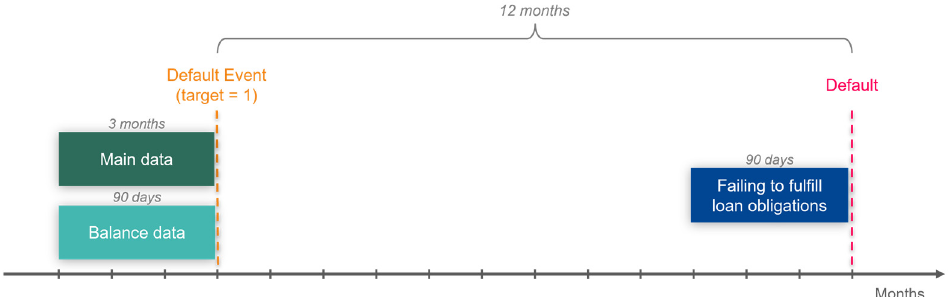
Figure 2. Timeline illustrating the distinction between default and legal default. Ninety days of balance data and three months of main data are used for predicting the probability of a legal default within the next 12 months. A legal default occurs if a customer fails to fulfil its obligations over a period of 90 days.